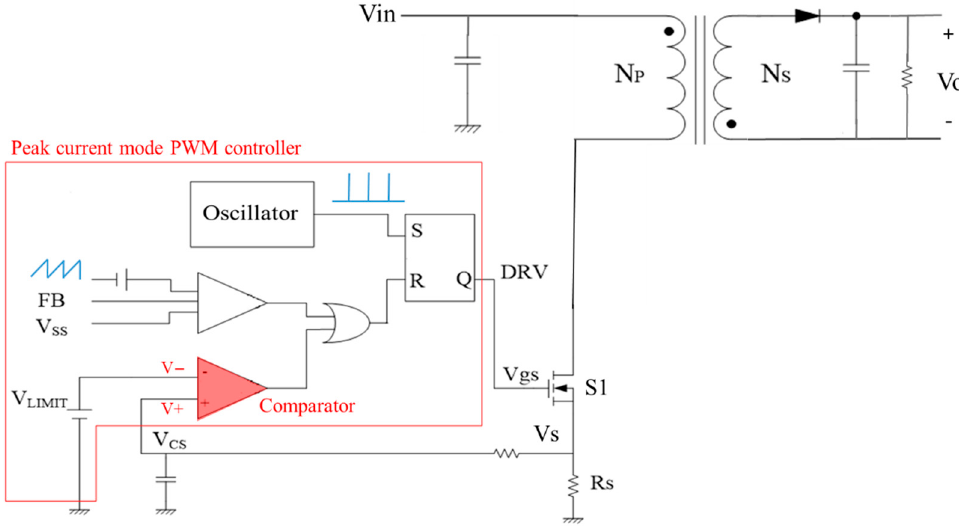
Figure 1. A typical flyback converter with primary side peak current mode control.